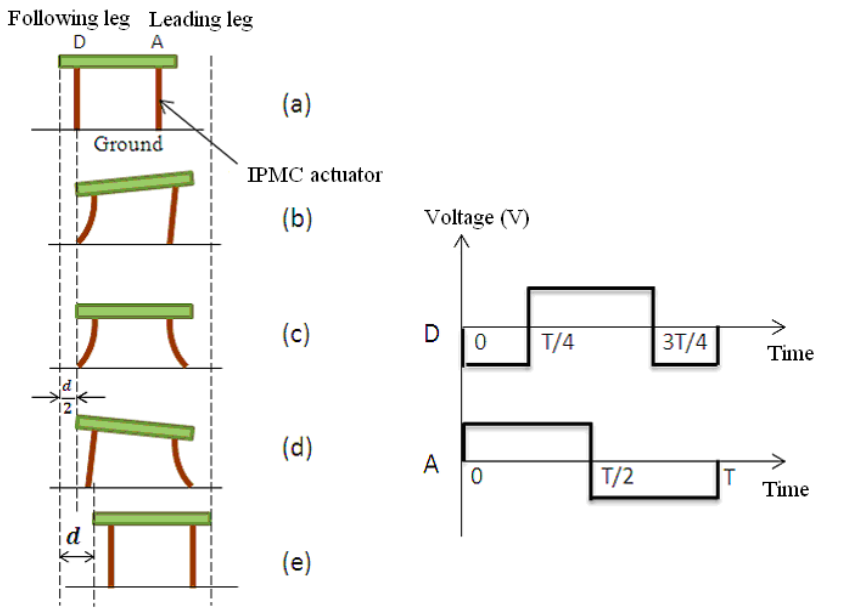
Figure 19. One step cycle of crawling motion in standing attitude